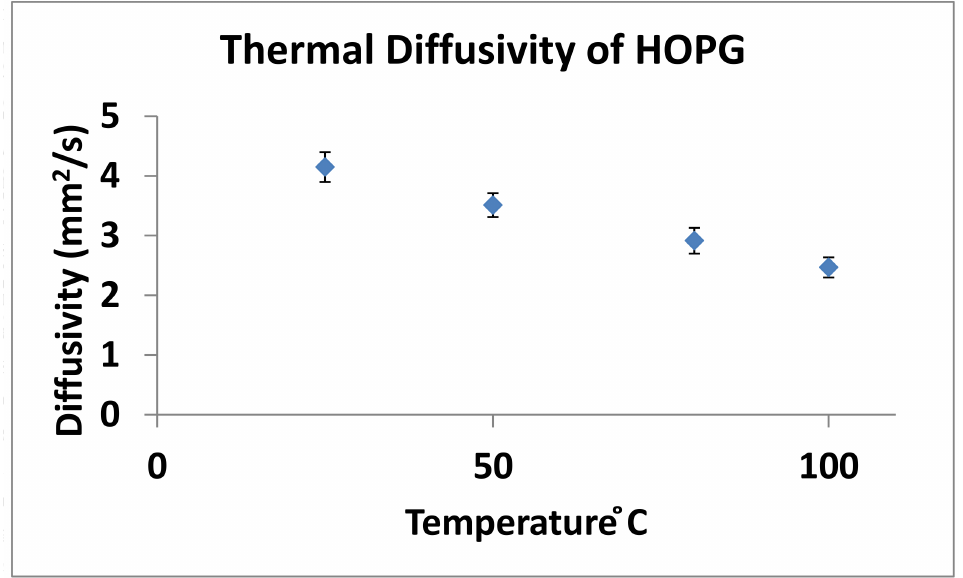
Figure 3. Diffusivity values for uncoated HOPG samples and samples painted with